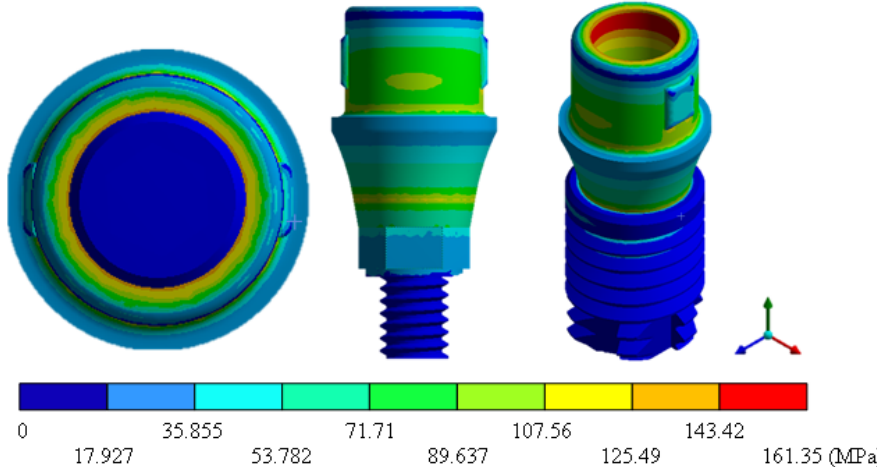
Figure 14. Von Mises stress for Universal-type implant (Ti 6 Al 4 V).